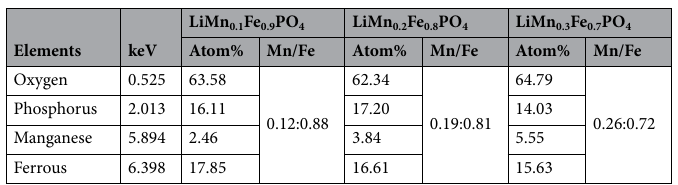
Table 2. Elemental composition of the Mn-doped olivines determined by